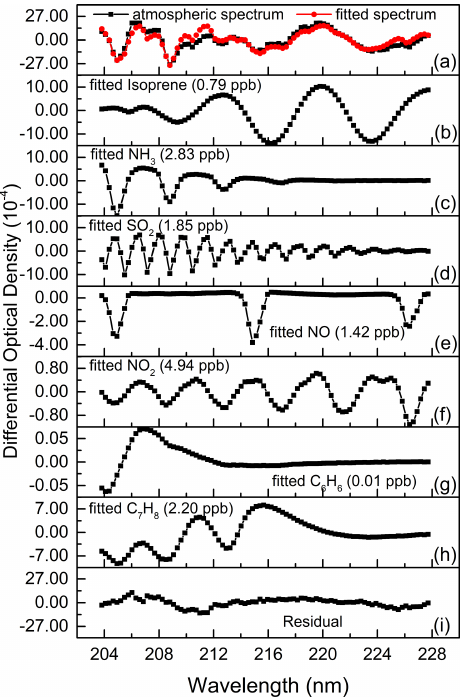
Figure 2. Example of the spectral fitting of an actual atmospheric spectrum (measured on 8 July 2018 at 12:47LT). Table 2. The calibration results in different gas cell combinations. Length of cells C E